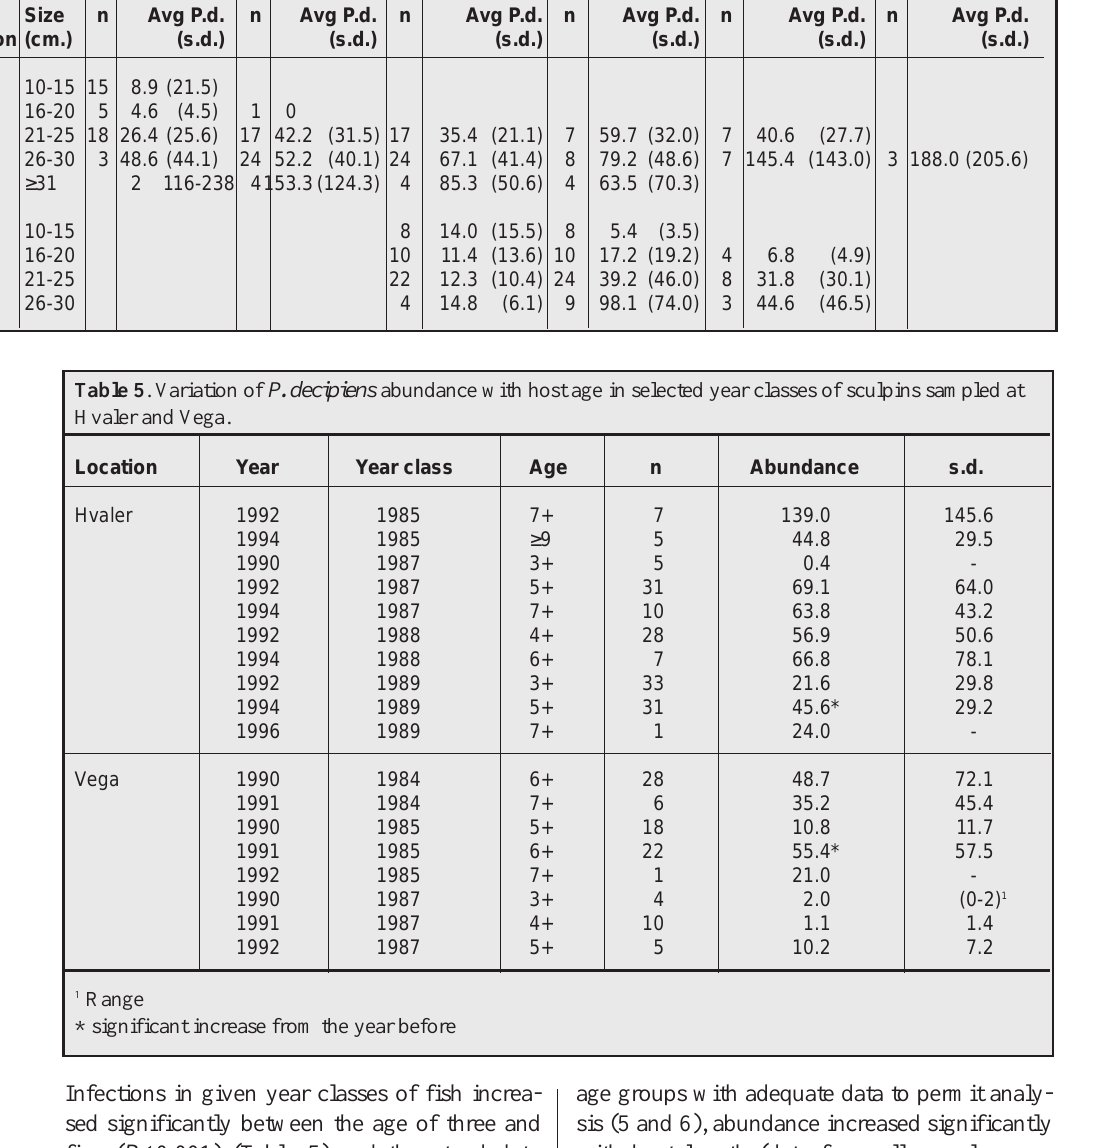
Table 4 . Variation of sealworm abundance with host length at Hvaler and Vega between 1991 and 1996. Age